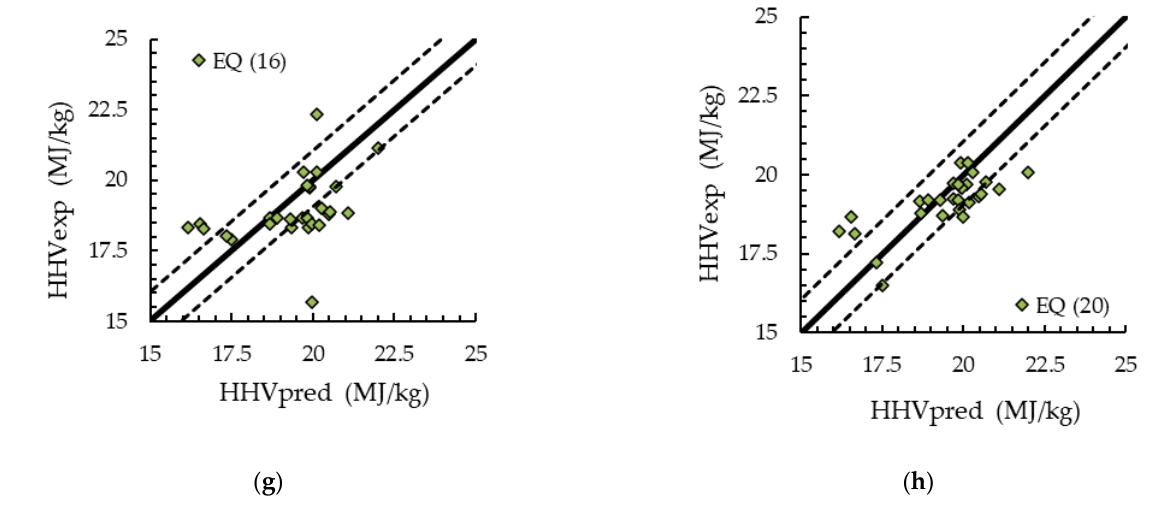
Figure 10. Comparison of the predicted and experimental values for HHVs based on proximate analysis using different authors ’ equations: ( a ) Equation (3); ( b ) Equation (5); ( c ) Equation (4); ( d ) Equation (10); ( e ) Equation (8); ( f ) Equation (12); ( g ) Equation (16) and ( h ) Equation (20).